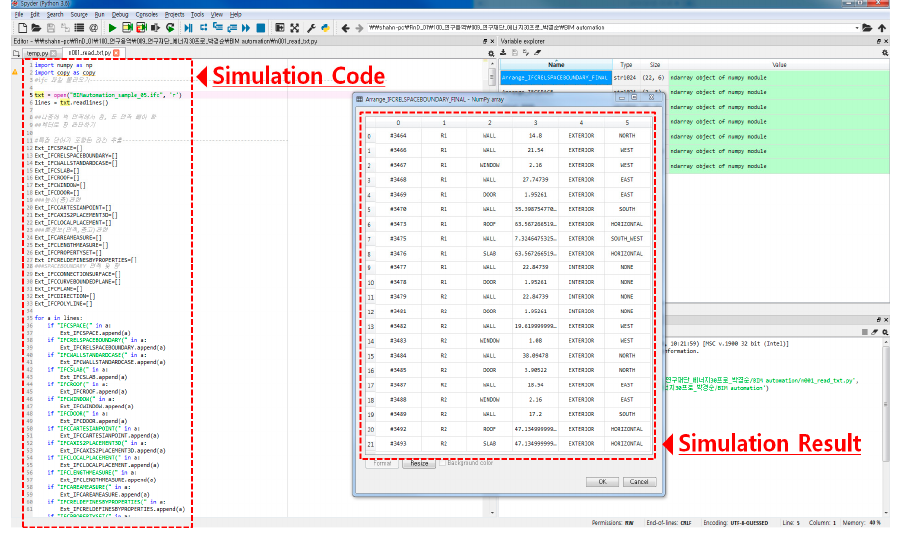
Figure 3. Geometry information extraction module.